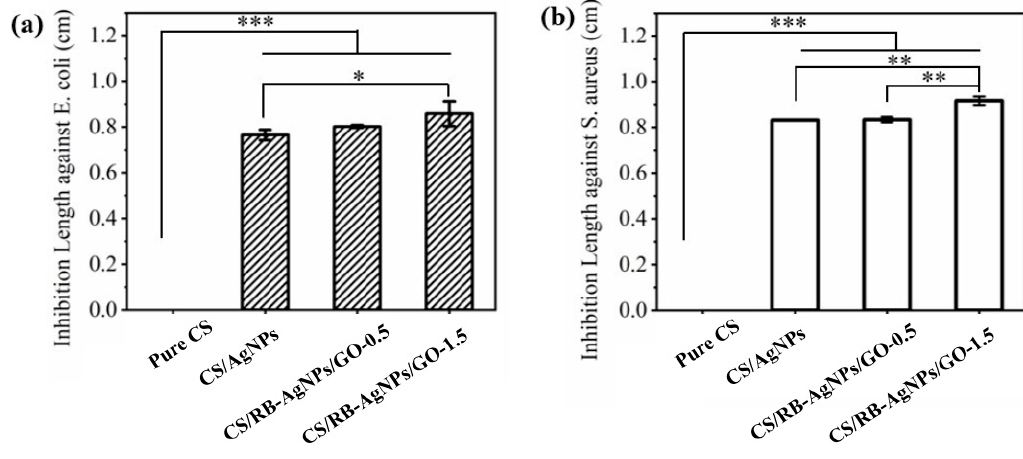
Figure 8. Inhibition lengths of different samples against ( a ) E. coli , and ( b ) S. aureus of different samples ( n = 3), *** p < 0.001, ** p < 0.01, * p < 0.05 vs. pure